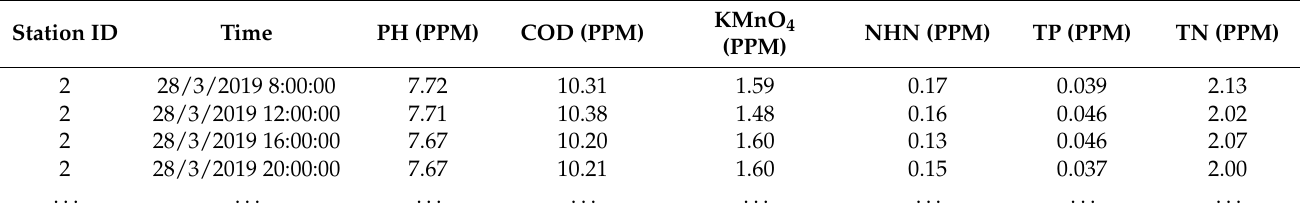
Table 1. Cross-section monitoring data of the Lanzhou section of the Yellow